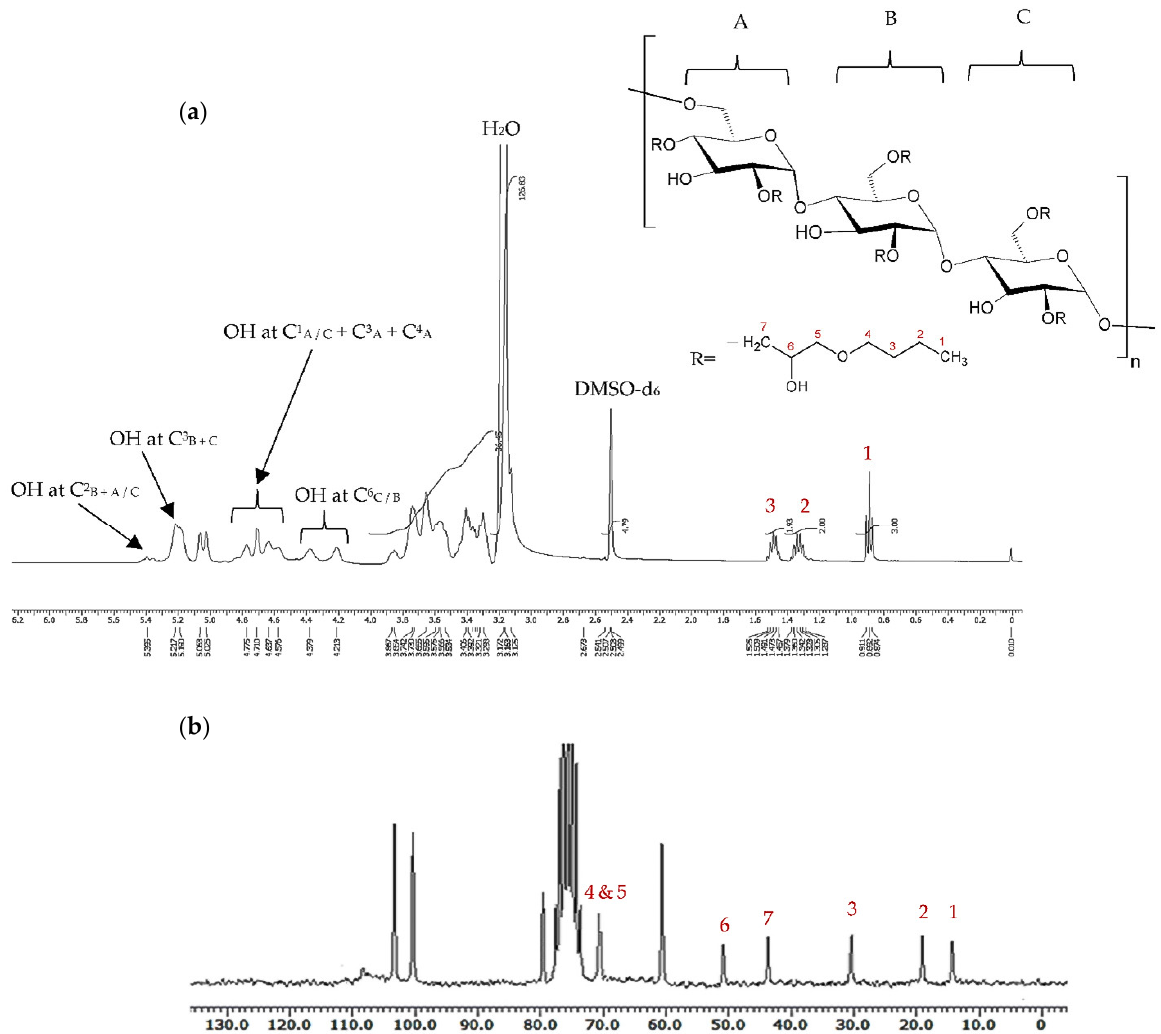
Figure 3. Typical 1 H-NMR ( a ) and 13 C-NMR ( b ) spectra of BMO-PUL in DMSO-d 6 (7 mg/mL). The three sugar rings of BMO-PUL were ascribed as A, B, and C.